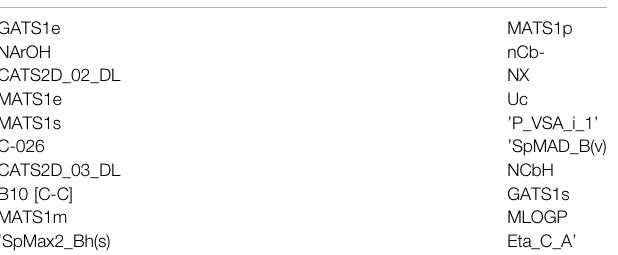
TABLE 7 | List of the top-20 high ranked variables that are included in the KNN model.